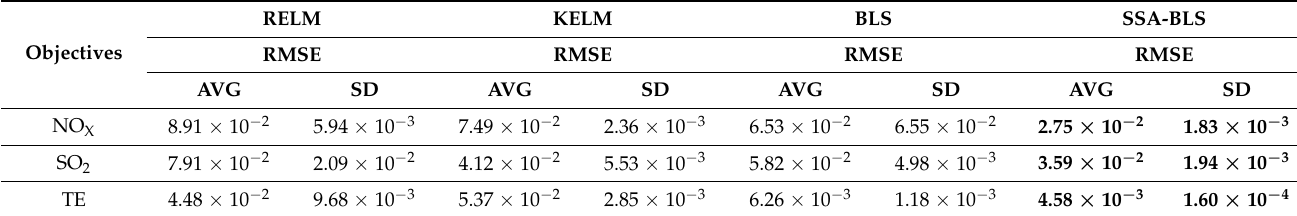
Table 10. The RMSE of the four algorithms on the testing set of boiler data.